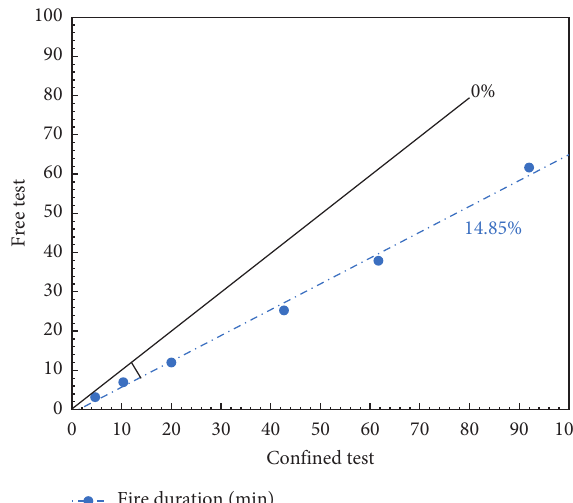
Figure 16: Angle of the shift of the effect of confining on the duration of fire.